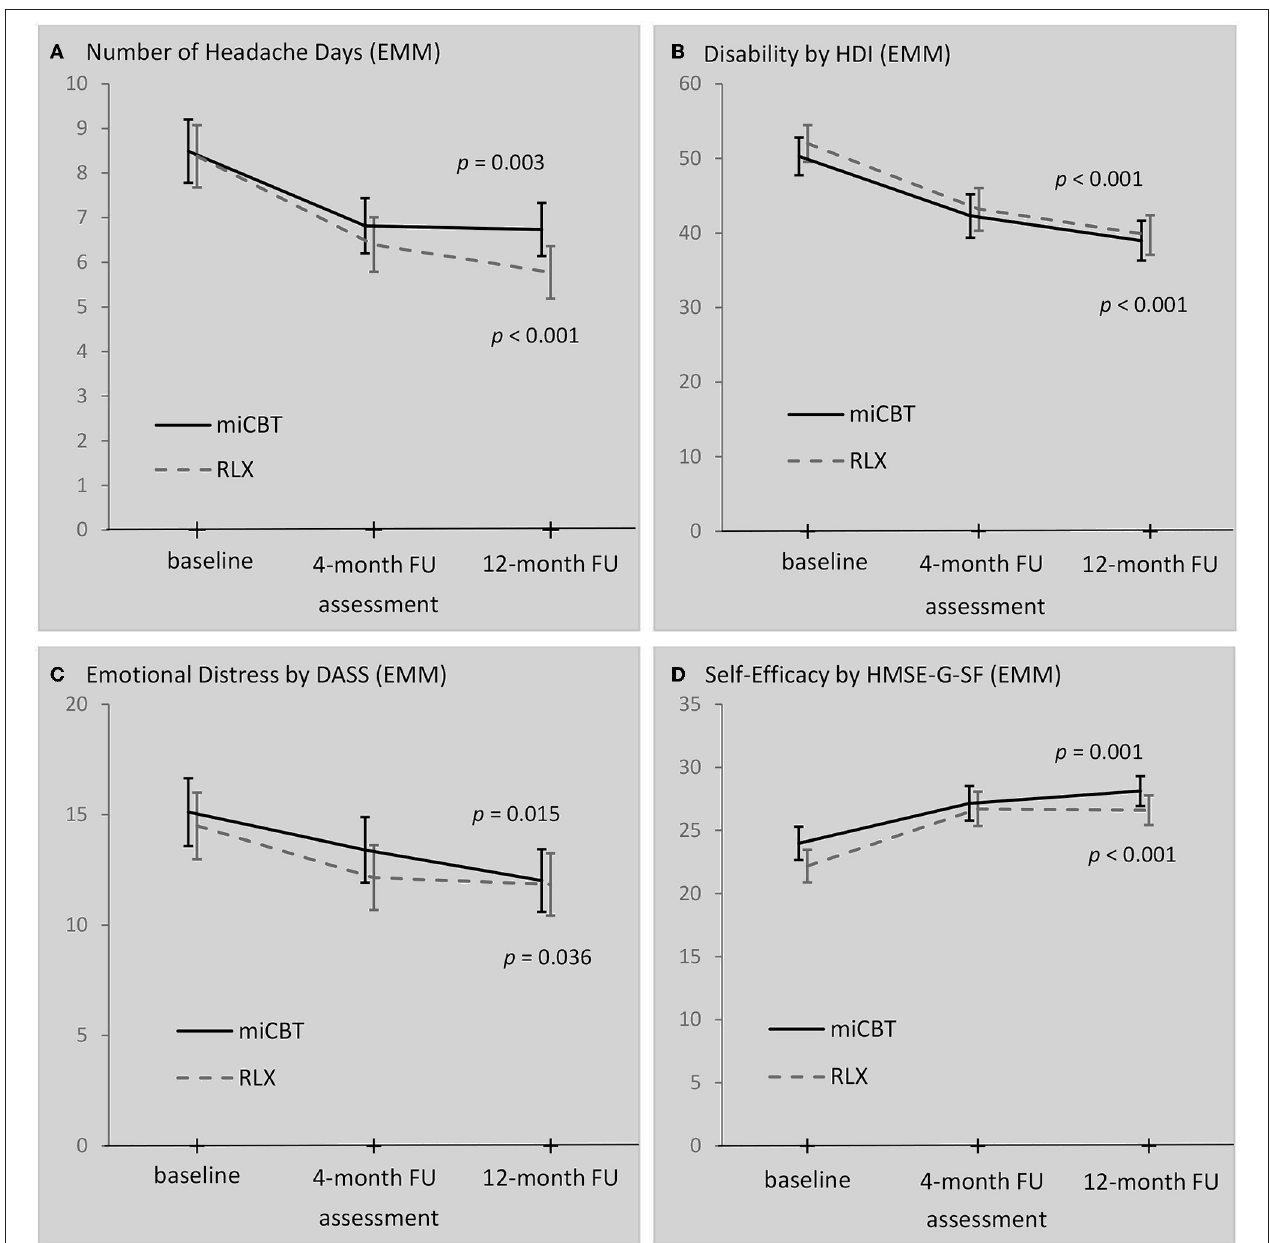
FIGURE 3 | Primary outcomes (by intention-to-treat, N = 104) of the follow-up analyses. (A) Headache days each refer to a 28-day period. (B) HDI and (C) DASS: Higher values mirror higher burden. (D) HMSE-G-SF: higher values mirror higher self-efficacy. Values are based on estimated marginal means (EMM). The error bars present the standard error. Assessment is at baseline, 4-months post-treatment, and 12-months post-treatment. Analyses used a linear mixed model for repeated measures. The p -value each refers to a within-group comparison from baseline to 12-month follow-up (miCBT: upper p -value; RLX: lower p -value). Since two participants of the waiting-list control group were not allocated to one of the two treatment conditions for the follow-up, N = 104 ( Figure 2 ). miCBT, migraine-specific, integrative cognitive-behavioral therapy program; RLX, relaxation training; EMM, estimated marginal means; FU, follow-up; HDI, Headache Disability Index; DASS, Depression, Anxiety and Stress Scales, total score; HMSE-G-SF, Headache Management Self-Efficacy Scale, German version, Short-Form.